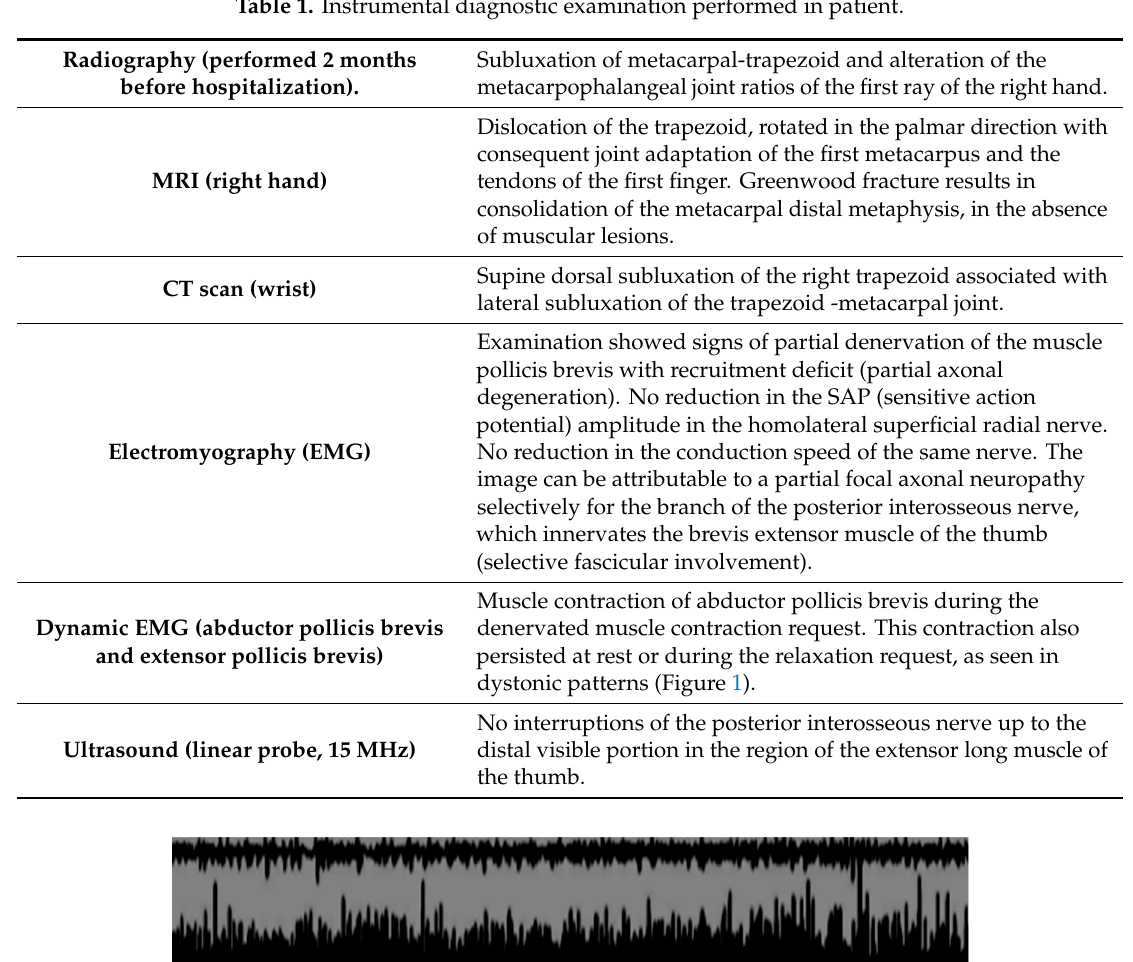
Table 1. Instrumental diagnostic examination performed in patient.